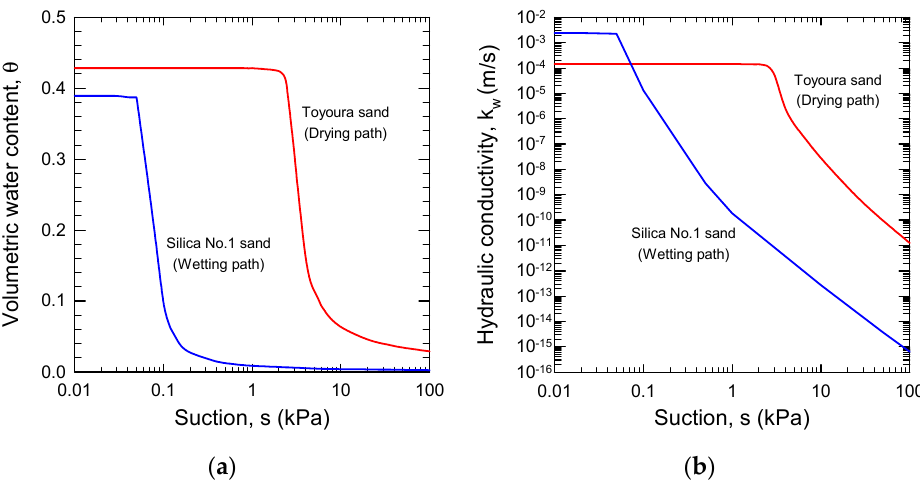
Figure 3. SWCCs and hydraulic conductivities of Toyoura sand and silica sand No. 1: ( a ) SWCCs; ( b ) hydraulic conductivities. Table 2. Fitting parameters for the SWCCs. Soil Sample